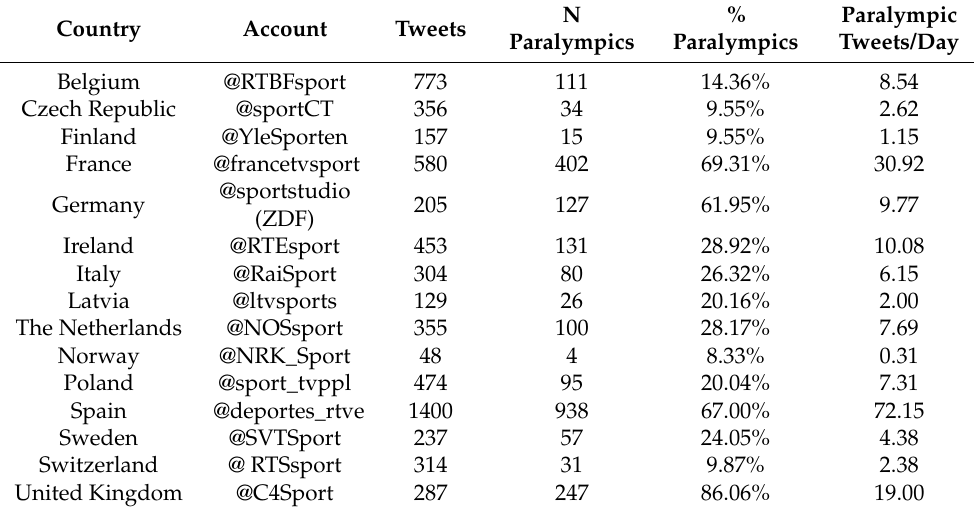
Table 2. Volume and frequency of the analyzed